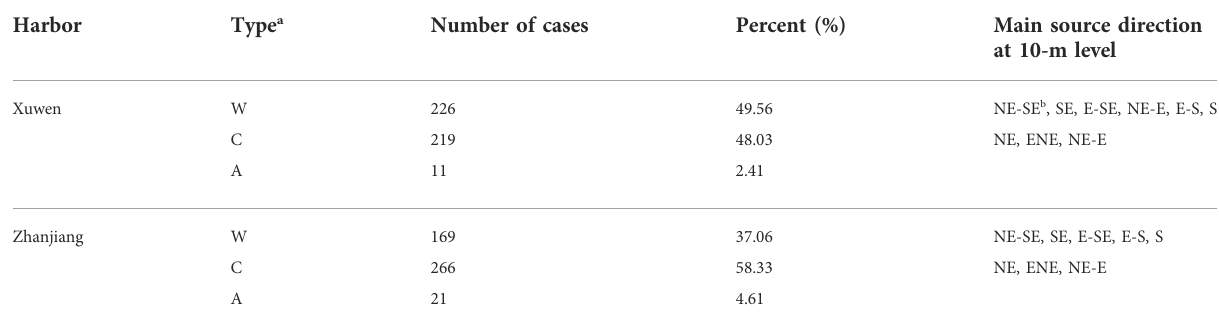
TABLE 2 Main characteristics of advection fog cases for 2013 – 2021.